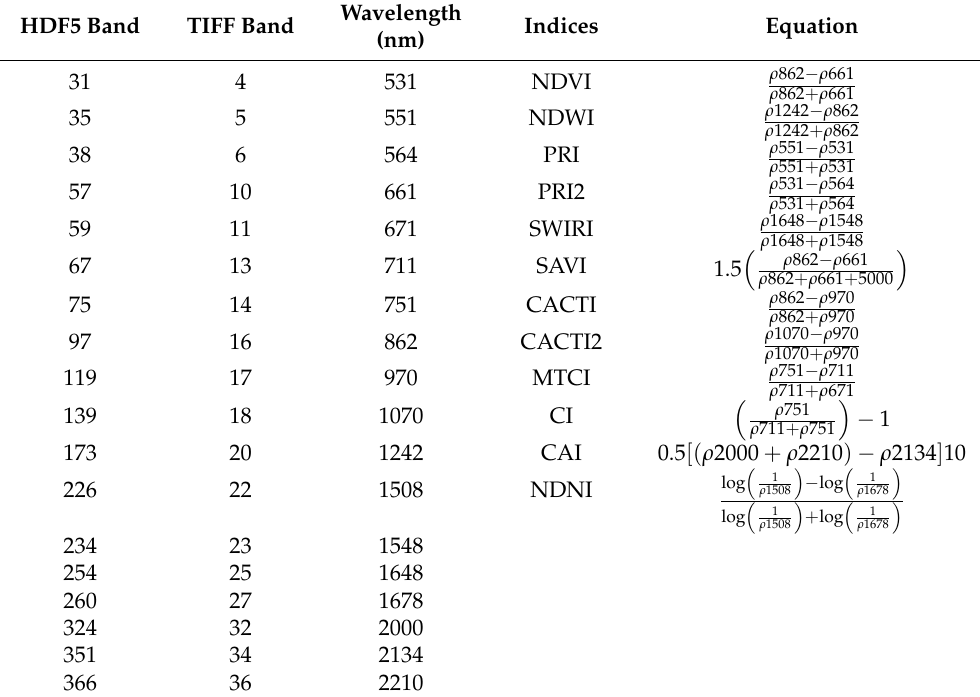
Table 1. Band numbers, respective wavelengths, and vegetation indices that were used in the study with their respective formulas and the references. ρ is used to reference a specific band number that corresponds to a wavelength in nm. Wavelength HDF5 Band TIFF Band (nm)